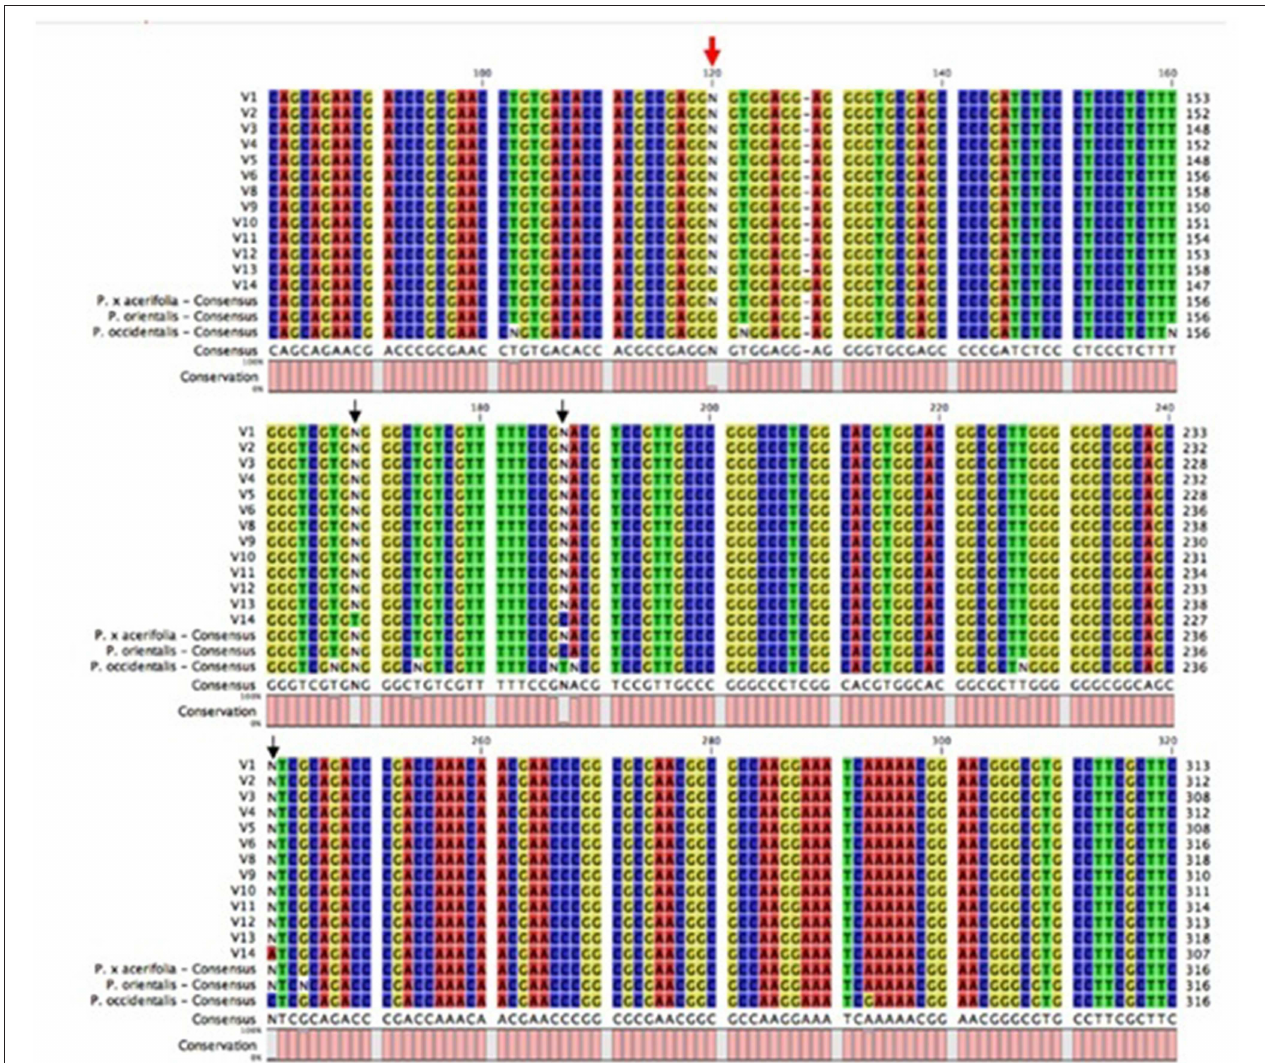
FIGURE 5 | Comparison of the ITS nuclear rDNA region from the Platanus samples and published P. × acerifolia , P. orientalis , and P. occidentalis consensus sequences. A red arrow at the relative position 120 shows the discriminating polymorphism. Small black arrows indicate other